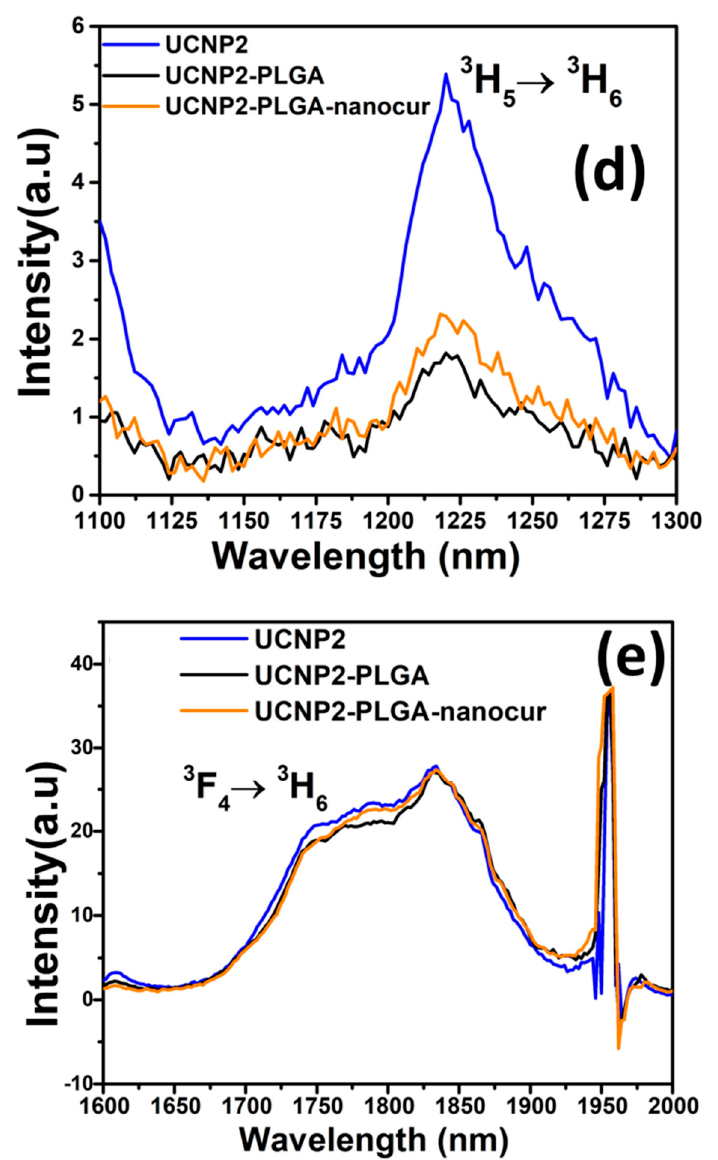
Figure 6. ( a ) UCL spectra of UCNP1, UCNP1-PLGA and UCNP1-PLGA-nanocur, ( b ) fluorescence spectra of UCNP1, UCNP1-PLGA, ( c ) UCL spectra of UCNP2, UCNP2-PLGA and UCNP2-PLGA- nanocur ( d , e ) fluorescence spectra of UCNP2, UCNP2-PLGA and UCNP2-PLGA-nanocur,